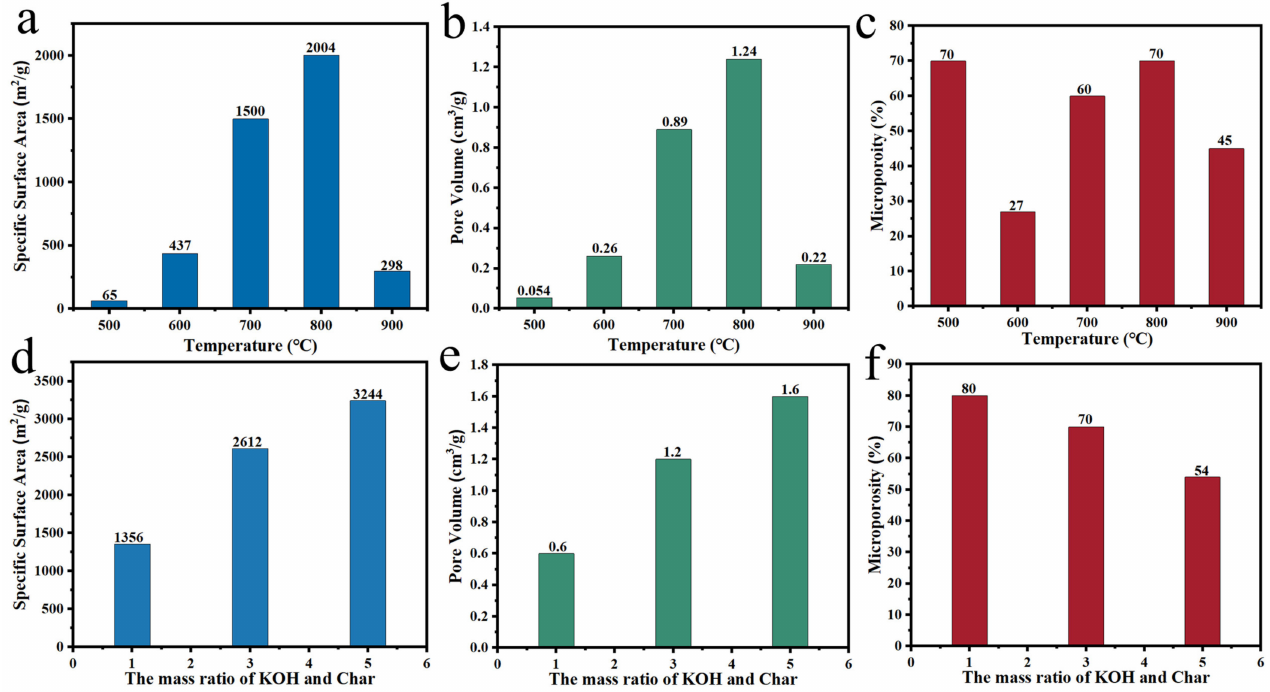
Figure 6. ( a – c ) Impact of temperature on KOH activation effect [70]; ( d – f ) Impact of char/alkali mass ratio on KOH activation effect